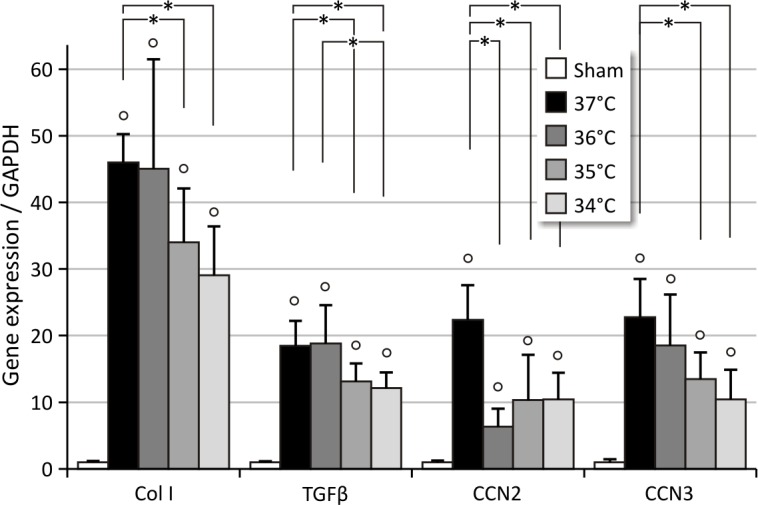
Relative quantification of long-term IRI-induced expression of fibrosis-related genes.Core body temperature during ischemia determines degree of long-term fibrotic outcome. *: p<0.05, °: p<0.05 vs. Sham. UIRI was performed for 30 minutes at 37°C (n = 5), 36°C (n = 4), 35°C (n = 10) or 34°C (n = 5) and animals were euthanized 12 weeks after UIRI. Twelve weeks after UIRI, a significant increase in gene expression of fibrosis-related genes Col I, TGFβ, CCN2 and CCN3 was observed in renal cortex tissue in all core body temperature conditions tested. The expression of these genes is also temperature-dependent: higher expression with higher temperature during ischemia. The bars are the means ± s.d. The data were analysed using a two-tailed Mann-Whitney U test.